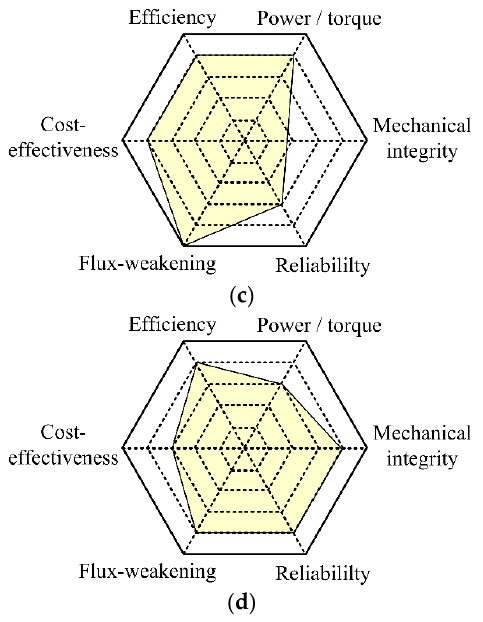
Figure 9. Evaluations on key criteria: ( a ) Prius; ( b ) PS-SFPM; ( c ) FA-PS-SFPM; ( d ) PS-SFDE. Table 2. Key Machine Performance Comparisons, data of Prius are reproduced from [19].